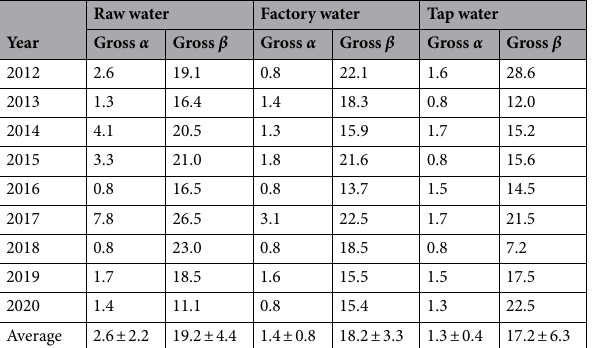
Table 3. Radioactivity concentrations of gross α and β for different types of drinking water samples around the Qinshan NPP from 2012 to 2020 (× 10 –2